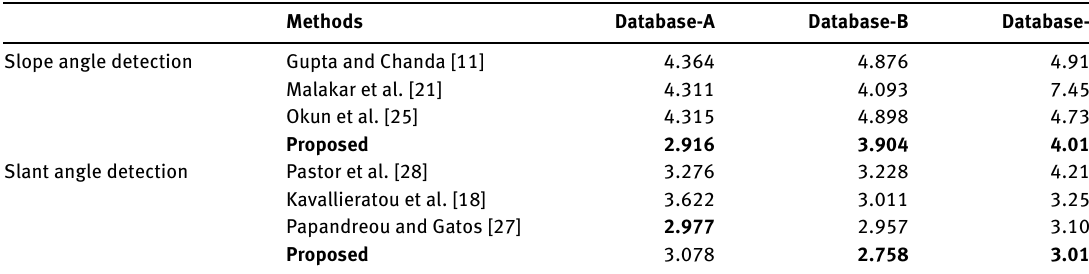
Table 3: Comparison of the Proposed Method with State-of-the-Art